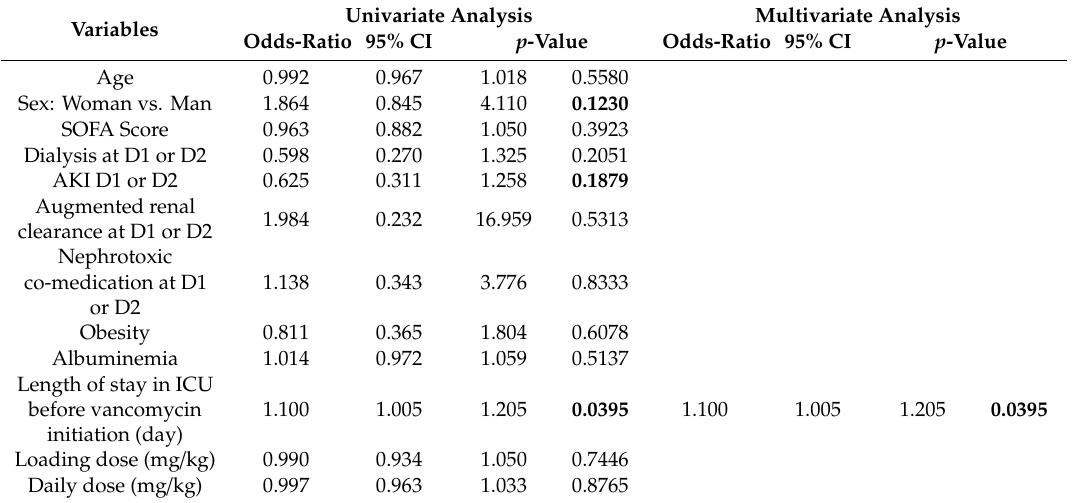
Table 4. Multivariate analysis for risk factors of being out of